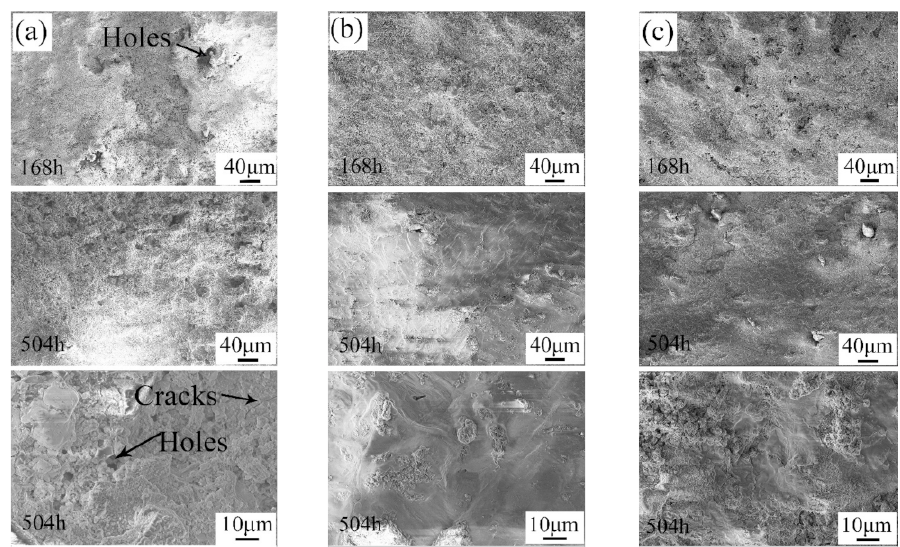
Figure 9. Microstructures of the corrosion layers of ( a ) the pit in the UR samples, ( b ) 7N01-T4, and ( c ) the repaired areas in the CS samples after alternate immersion tests.